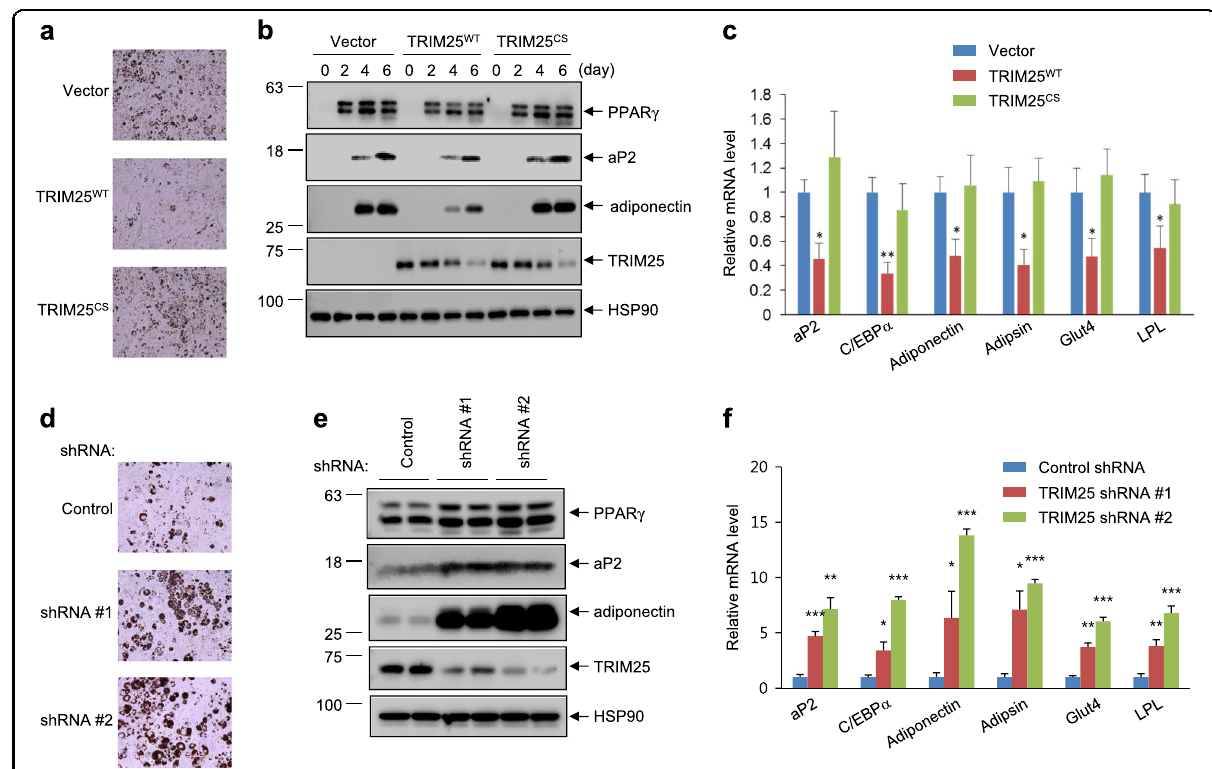
Fig. 6 TRIM25 suppresses adipocyte differentiation in 3T3-L1 cells. Stably expression of TRIM25 WT and TRIM25 CS ( a – c ) or shRNAs (#1 and #2) for TRIM25 ( d – f ) in 3T3-L1 pre-adipocytes was induced for 6 days. a , d Differentiated cells were stained by Oil Red O. b , e The protein expression of TRIM25, PPAR γ , and adipogenic markers was analyzed by western blotting. c , f The mRNA expression of adipogenic markers was analyzed by real- time quantitative PCR. All error bars shown are the s.e.m. (* p < 0.05, ** p < 0.01, *** p <